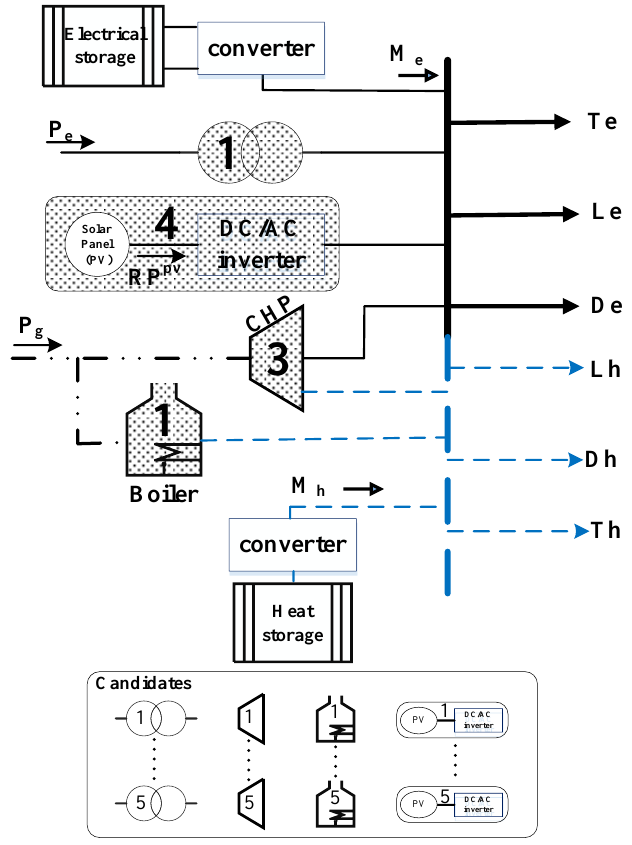
Figure 9. Design and Structure of proposed MCMG.